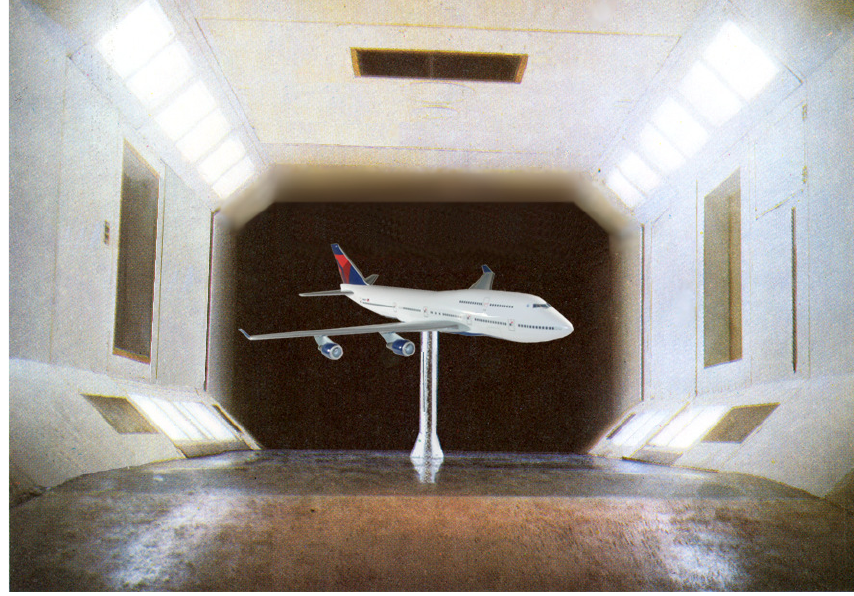
Figure 6. Photograph of the model airplane inside the wind tunnel.